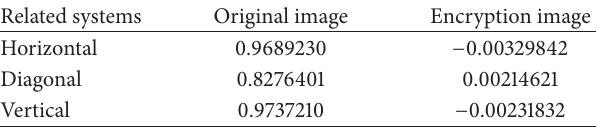
Table 5: The correlation among adjacent pixels of G component.